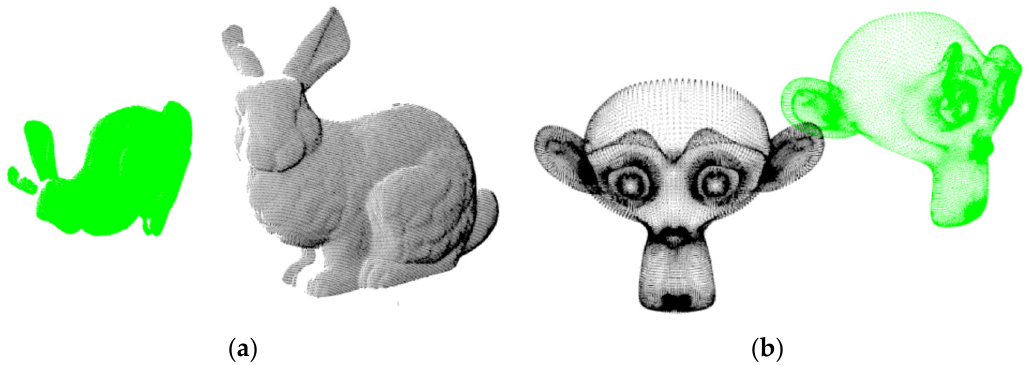
Figure 4. Initial state of point cloud. ( a ) Bunny; ( b ) Monkey.